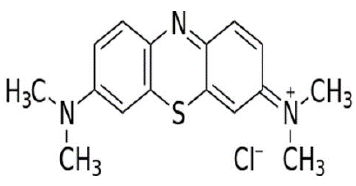
Fig. 11. Chemical structure of methylene blue dye Fig (11): Chemical structure of methylene blue dye [64].